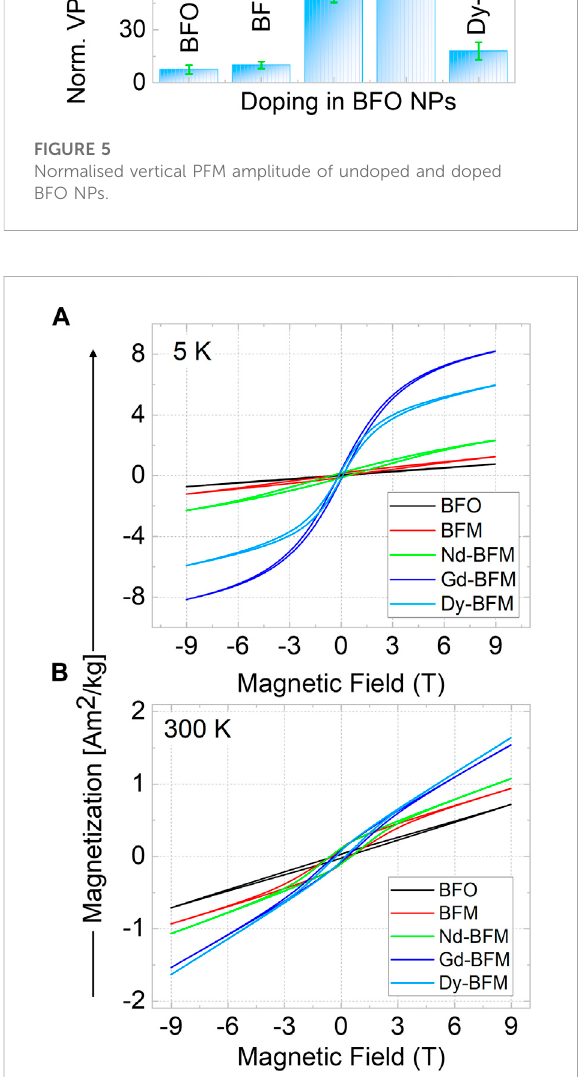
FIGURE 6 Magnetic hysteresis of pristine BFO, Mn-doped, and RE (Nd/ Gd/Dy) and Mn co-doped BFO NPs at 5 K (A) , and at 300 K (B) .